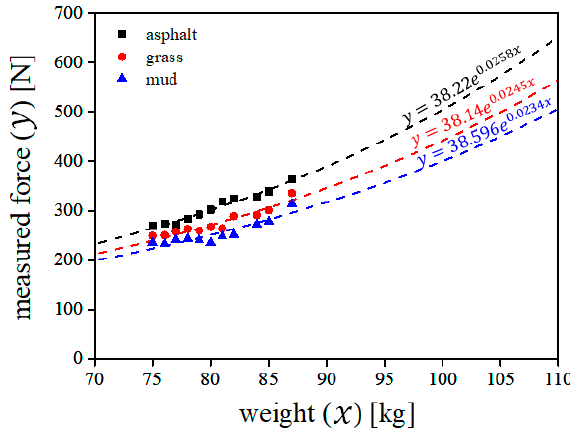
Figure 1. Result of the measured maximum resistive force.